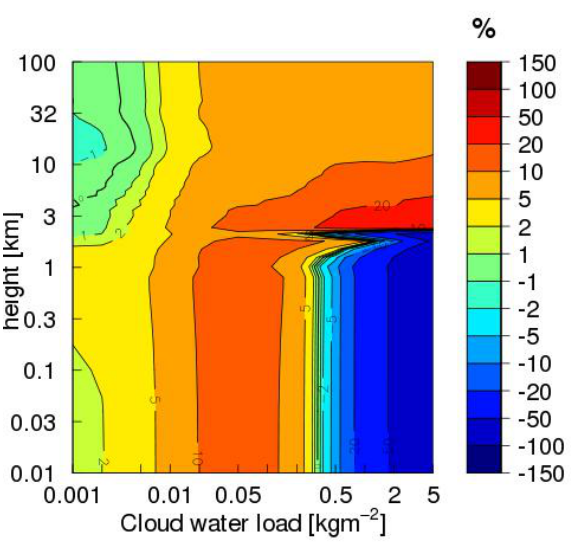
Figure 12. As for Fig. 11 but for IFS-Slingo vs. HS-DISORT.